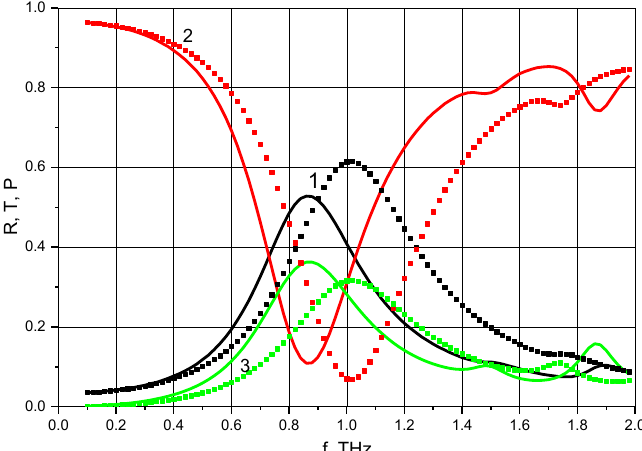
Fig. 2. Frequency dependences of the reflection, transmittance coefficients and losses in the resonance metasurface of single square graphene strip in the unit cell on the dielectric substrate: Curves 1 — R , 2 — T , 3 — P ; W = l= 5 0 μ m, a = b = 70 μ m; h =0.55 μ m; n=1.45: Parameters of graphene are T = 300 K, and τ = 1 ps. Solid lines μ c = 0.25 eV; dashed lines μ c = 0.35